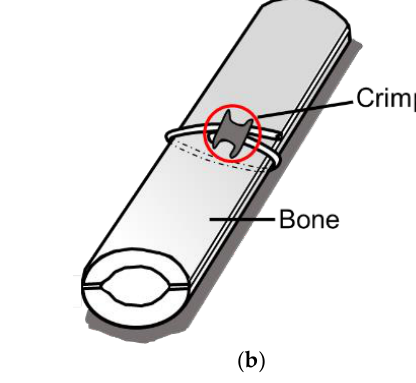
Figure 1. Type of cerclage ( a ) cerclage wire, ( b ) cerclage cable.